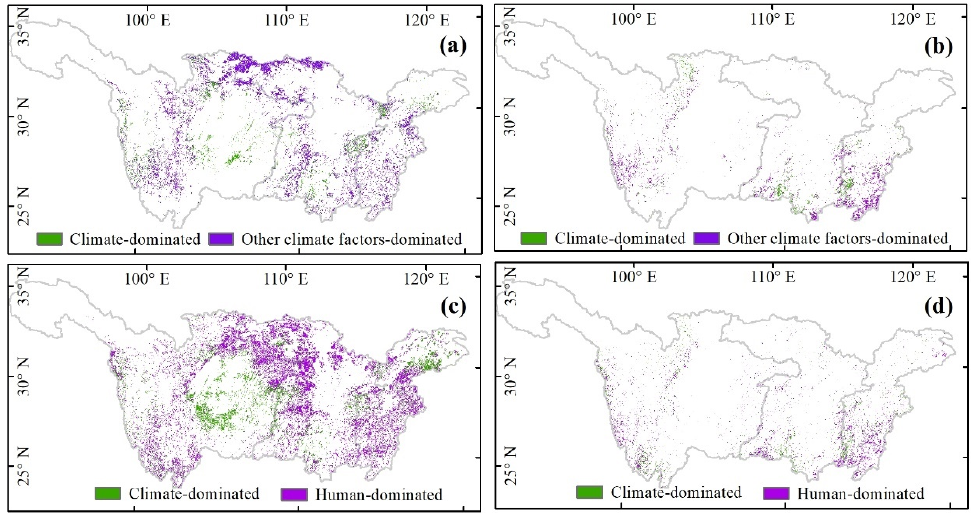
Figure 7. Spatial distribution of the climate-dominated, and other climate factors-dominated ( a , b ) new forest restoration and degradation areas, respectively; and the climate-dominated, and human-dominated ( c , d ) old forest restoration and degradation areas, respectively.